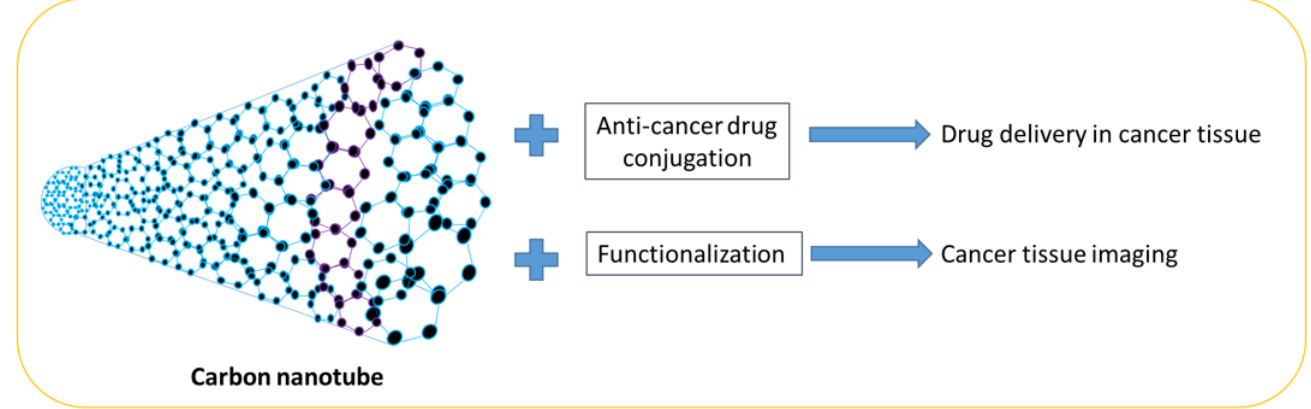
Table 8. Application of carbon nanotube-based nanomaterials as carriers in cancer cells.